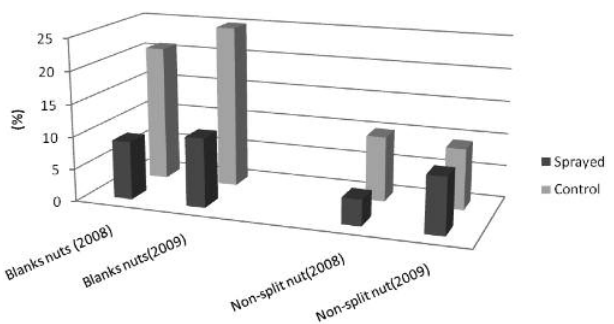
Figure 4. Blankness (%) and non dehisced nuts (%) in sprayed and control pistachio